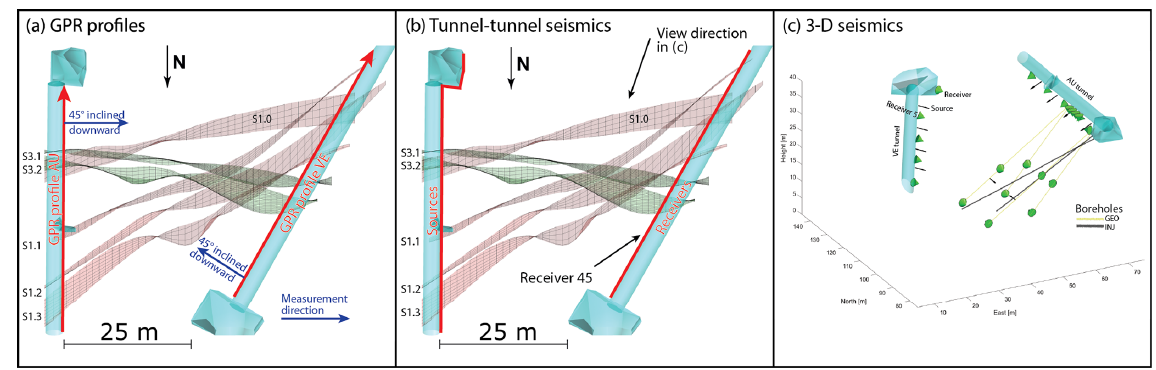
Figure 3. Acquisition geometry for the three geophysical data sets. GPR data were acquired using shielded antennas in the tunnels (a) , the 2-D seismic data were acquired between the AU and VE tunnels (b) , and the 3-D seismic data were acquired with both sources and receivers located in tunnels and boreholes (c)